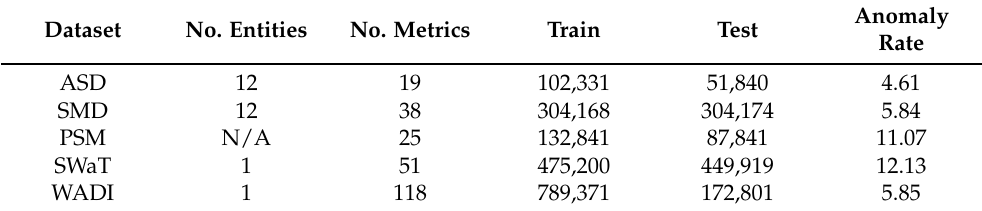
Table 1. Details of datasets.